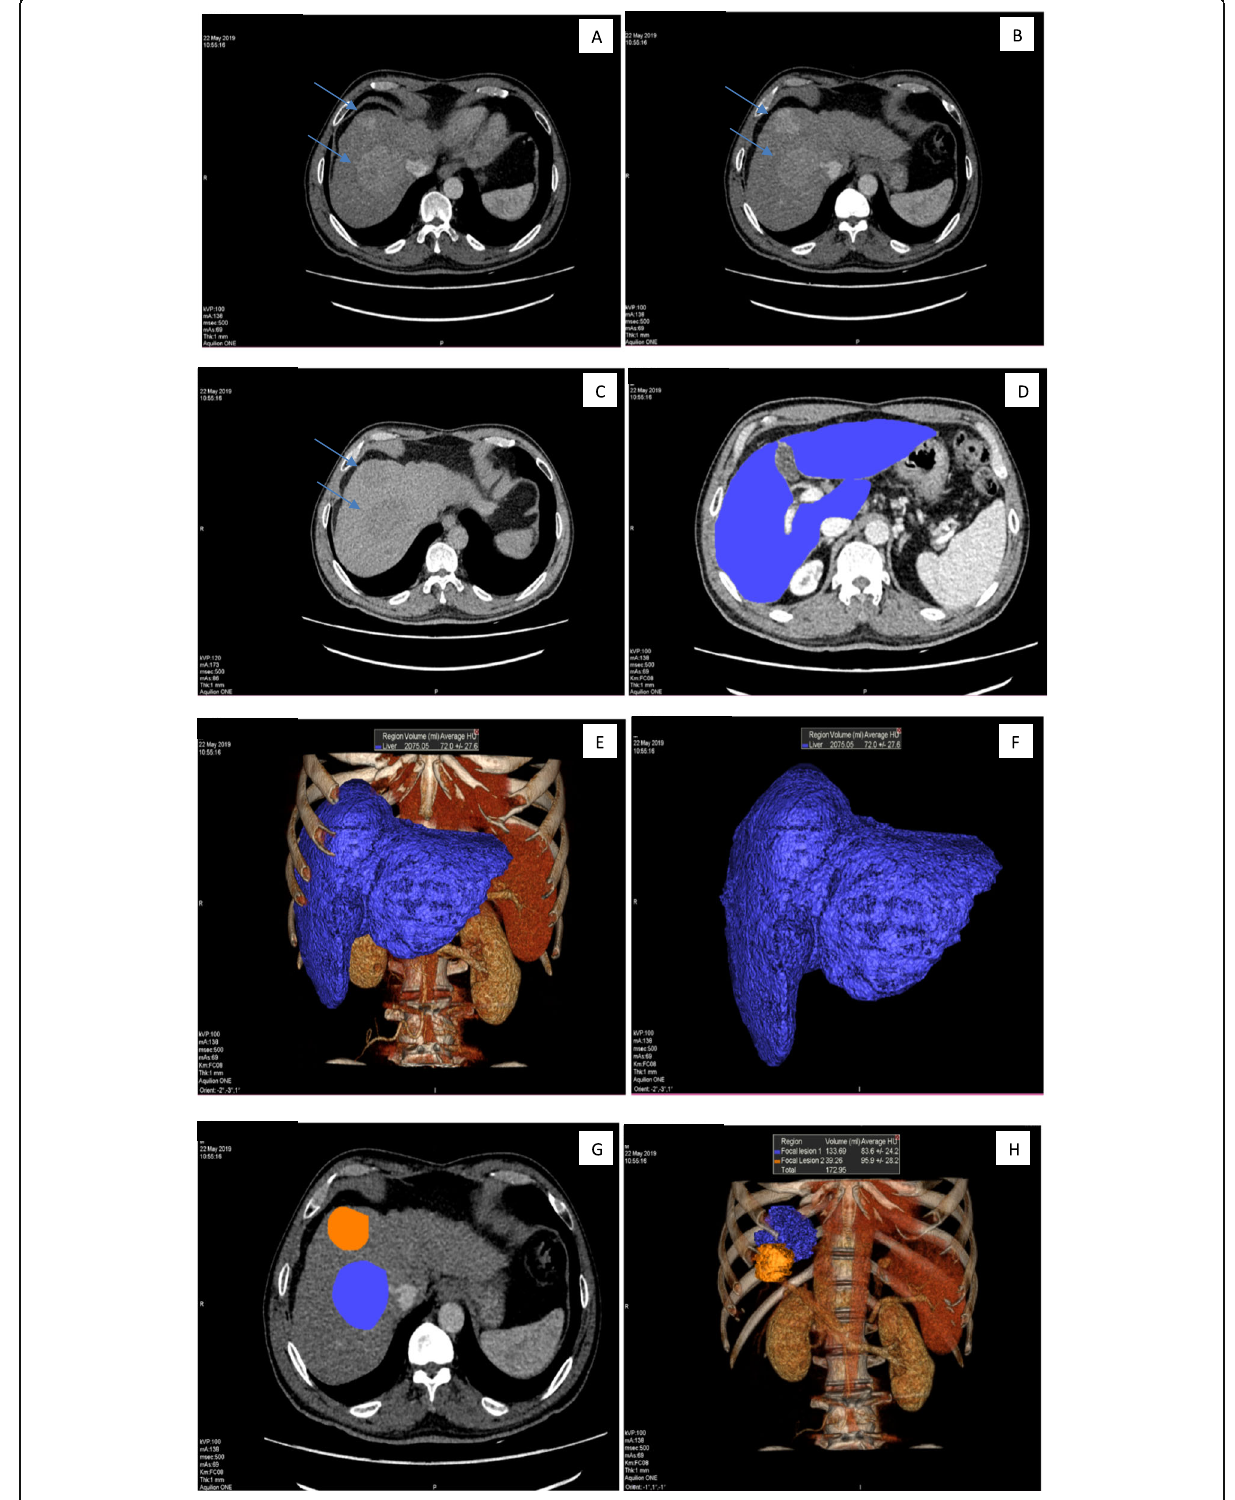
Fig. 3 Male patient aged 54 years old, with two right hepatic lobe focal lesions (HCC), triphasic CT examination axial arterial ( a , b ) and delayed ( c ) phase showing two right hepatic lobe focal lesions segment VIII, showing enhancement in arterial ( a , b ) with washout in delayed ( c ) phase. d – f CT volumetry of whole live (volume = 2075.05ml). g , h CT volumetry of the focal lesions (volume = 133.69 and 39.26